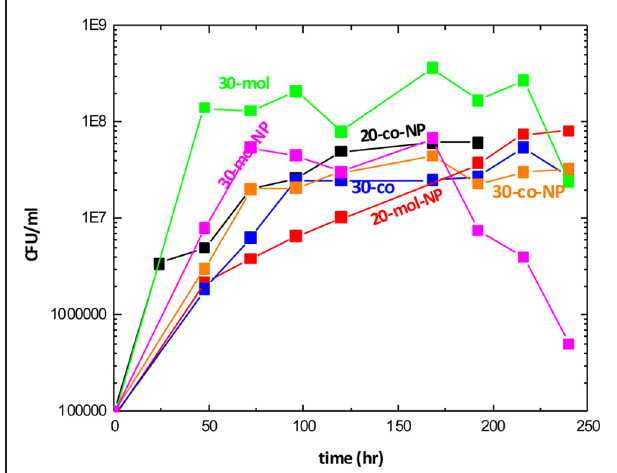
FIGURE 3 | Growth curves, colony forming units vs. time, under different conditions. (where mol, molasses and crude oil; co, crude oil; NP, additional nutrients and the number in the legend represents temperature).